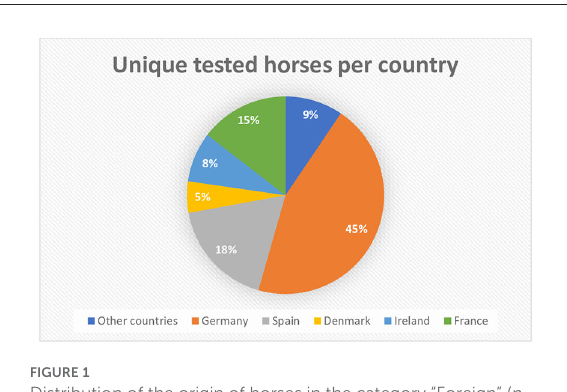
FIGURE1 Distribution of the origin of horses in the category “Foreign” ( n = 1,611), based on microchip numbers and country codes. 91% ( n = 1,466) of the horses originate from Germany, Spain, France, Ireland, and Denmark, constituting the top five, while 9% ( n = 145) of the horses in the category “Foreign” originate from other